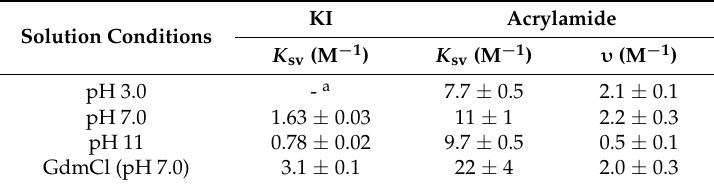
Table 2. Quenching parameters for LrtA under several conditions at 25 ◦